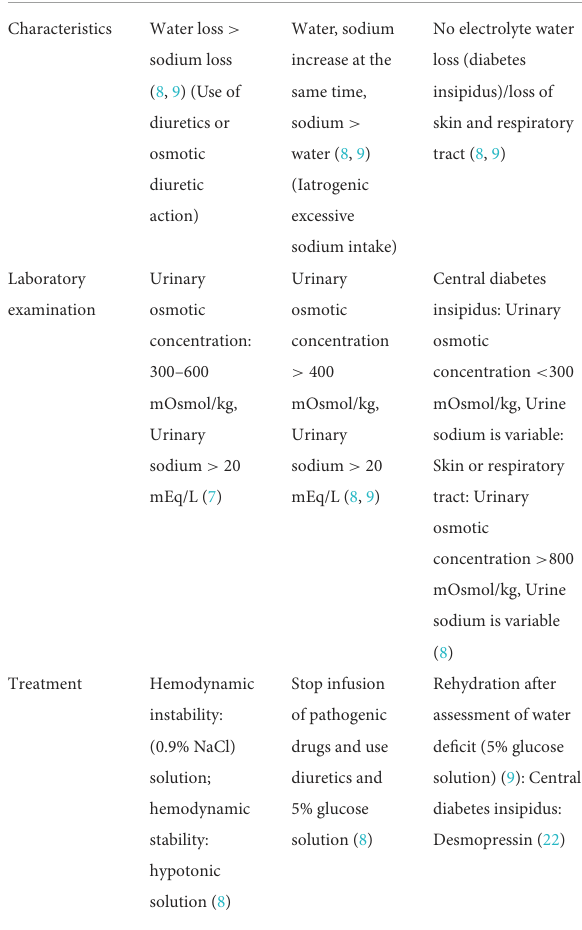
TABLE 1 Conventional treatment of brain injury with hypernatremia. Classification Hypovolemic Hypervolemic Normovolemic